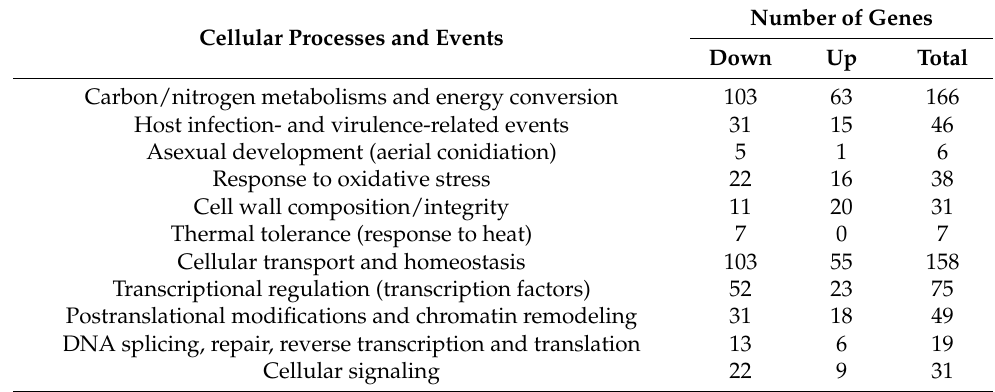
Table 1. Genome-wide impact of cre1 deletion on cellular processes and events crucial for the adaptation of B. bassiana to host insect and